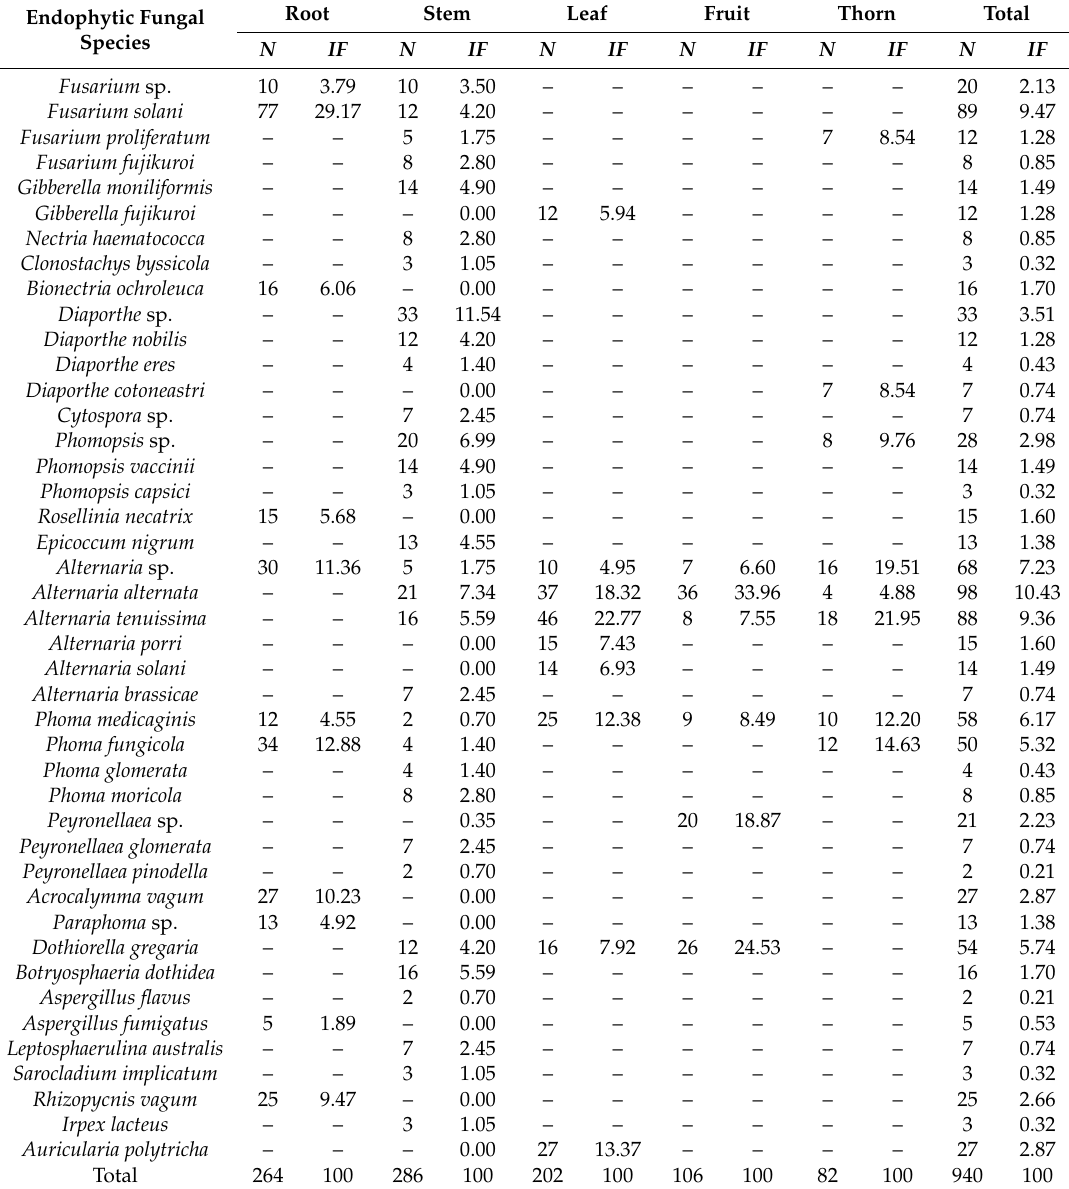
Table 3. Isolation frequency ( IF ) of each endophytic fungal species from Z. bungeanum . Endophytic Fungal